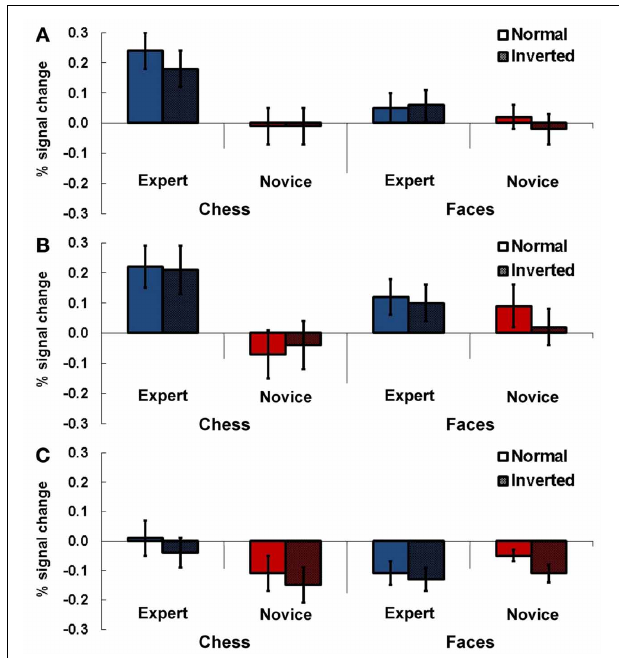
FIGURE 3 | Results Experiment 1. Percent signal change (PSC) for the two experimental conditions chess and faces (normal and inverted presentation) for experts and novices. Subjects had to indicate whether the currently presented stimulus matched the previously presented stimulus. Results are presented for TPJ ROI right (A) , left anterior (B) and left posterior TPJ (C) . Error bars indicate standard error of the